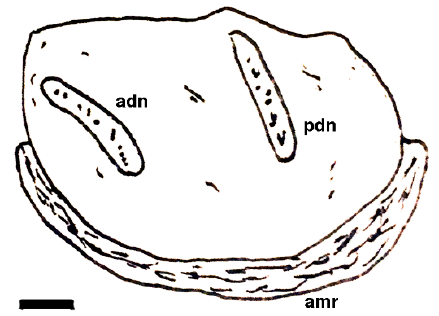
Figure 24. Navarana pearylandica . Anterior to left. Scale bar 100 microns. Abbreviations: adn , anterodorsal node; amr , admarginal rim; pdn , posterodorsal node. Image Credit: Mark McMenamin. Neoduibianella Shu, 1990 [70]; Duibianellidae; Range: Middle Stage 3; with question to early Drumian.